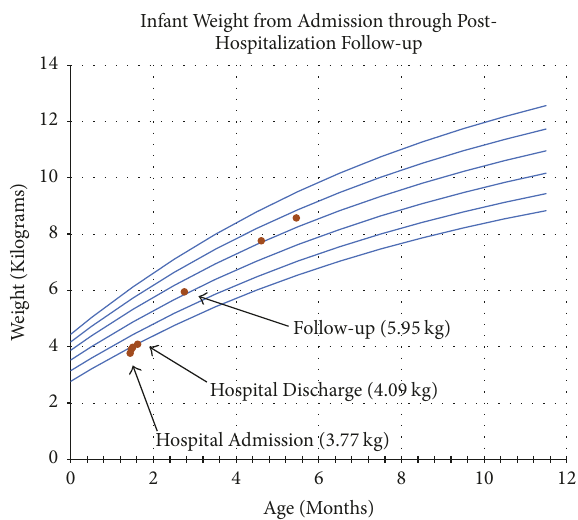
Figure 2: This is a copy of the infant’s growth chart. The infant was admitted to the PICU and was 3.77 kilograms (kg), which was below his birth weight and at the 6th percentile for age. He was discharged weighing 4.09 kg and at posthospitalization follow-up (6weeks from discharge) he was 5.95 kg, approximately the 52nd percentile for